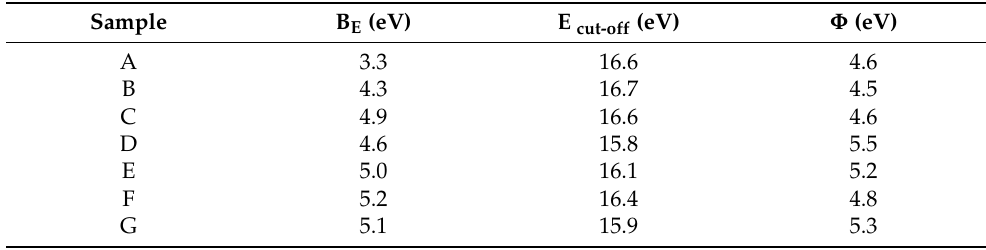
Table 4. Fermi energy, low energy cutoff, and work function calculations from Figure 9 for all the PCD